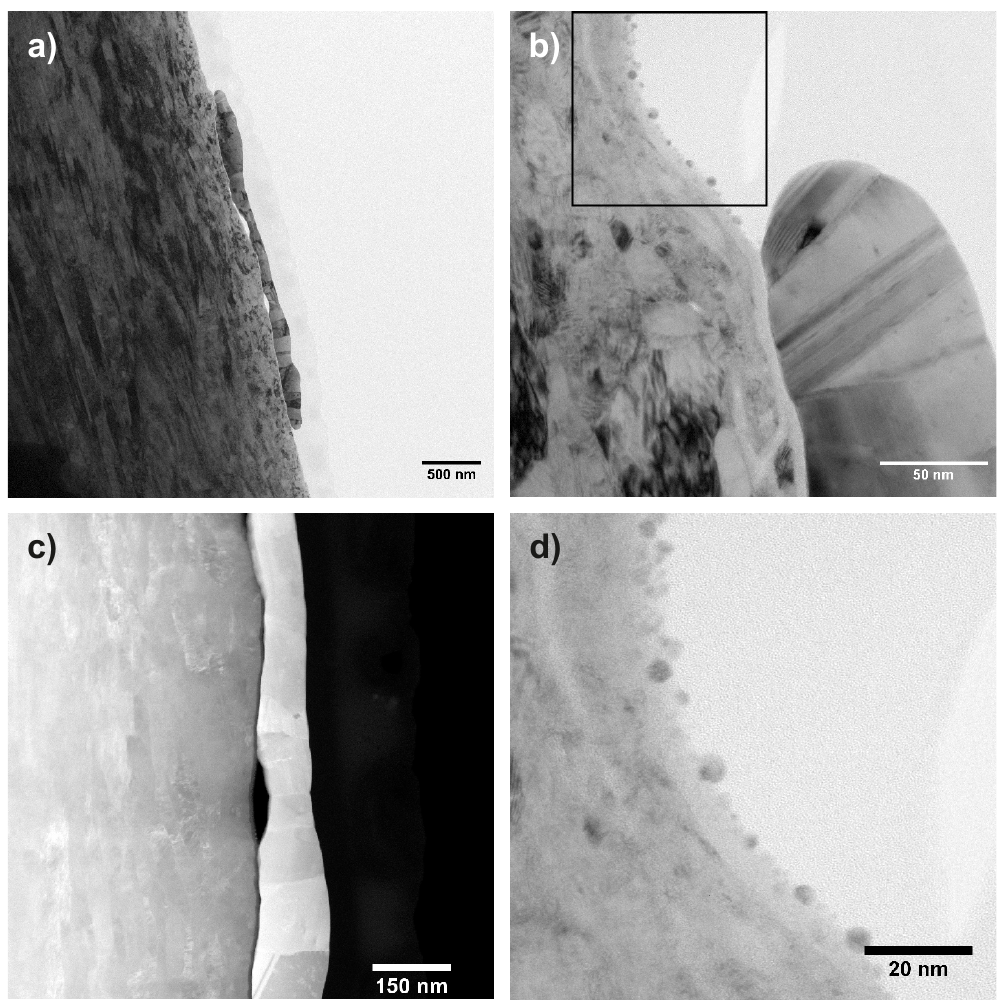
Figure 3. ( a ) bright field (BF) image of sample “Au”. A polycrystalline Au particle is visible in the middle part of the micrograph while on the left hand side the steel substrate can be seen; ( b ) details of the edge of the Au particle in higher magnification. The rectangle marks the area which was further digitally magnified; ( c ) STEM high-angle annular dark field (HAADF) image of the substrate and an Au particle; ( d ) digitally magnified part of the image marked in ( b ). Some Au nanoparticles are placed inside the oxide layer on top of the